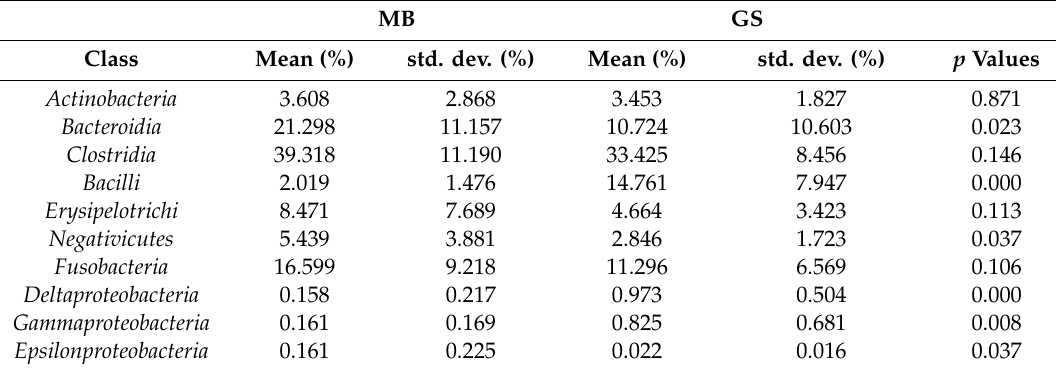
Table 2. Mean relative frequency of abundance (%) and corresponding standard deviation (SD) (%) of the classes identified in the caeca of mixed breeds (MB) and German Shepherd (GS) dogs. The species indicated are those showing a mean relative frequency of abundance ≥ 0.1% in at least one group. p values in bold are those who are significantly di ff